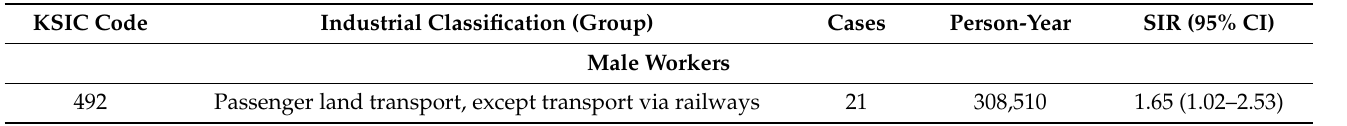
Table 3. Industry groups with a significantly higher risk of laryngeal